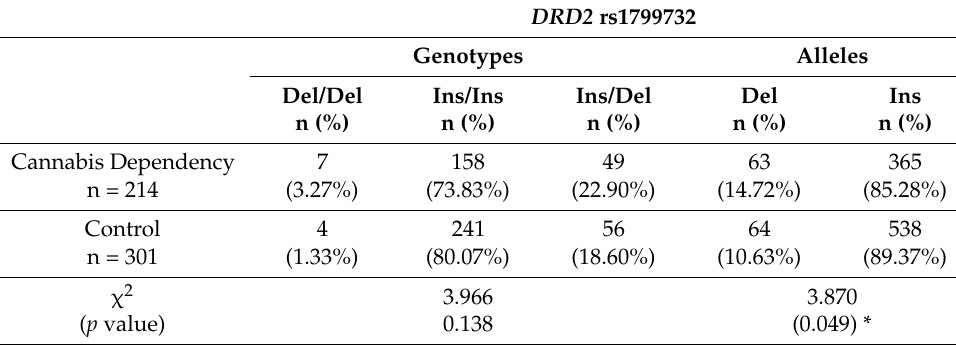
Table 2. Frequency of genotypes of the DRD2 gene rs1799732 gene polymorphisms in the Cannabis Dependency and control subjects.